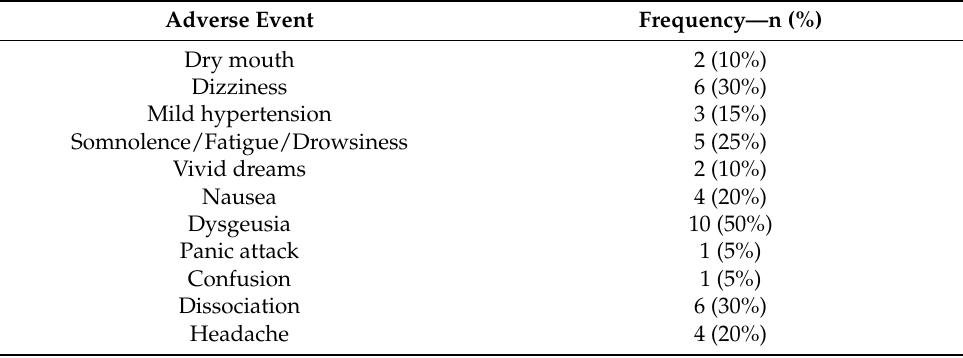
Table 2. Adverse events reported with systematic assessment using the ctcae Table 2 Adverse events reported with systematic assessment using the ctcae v4.0.